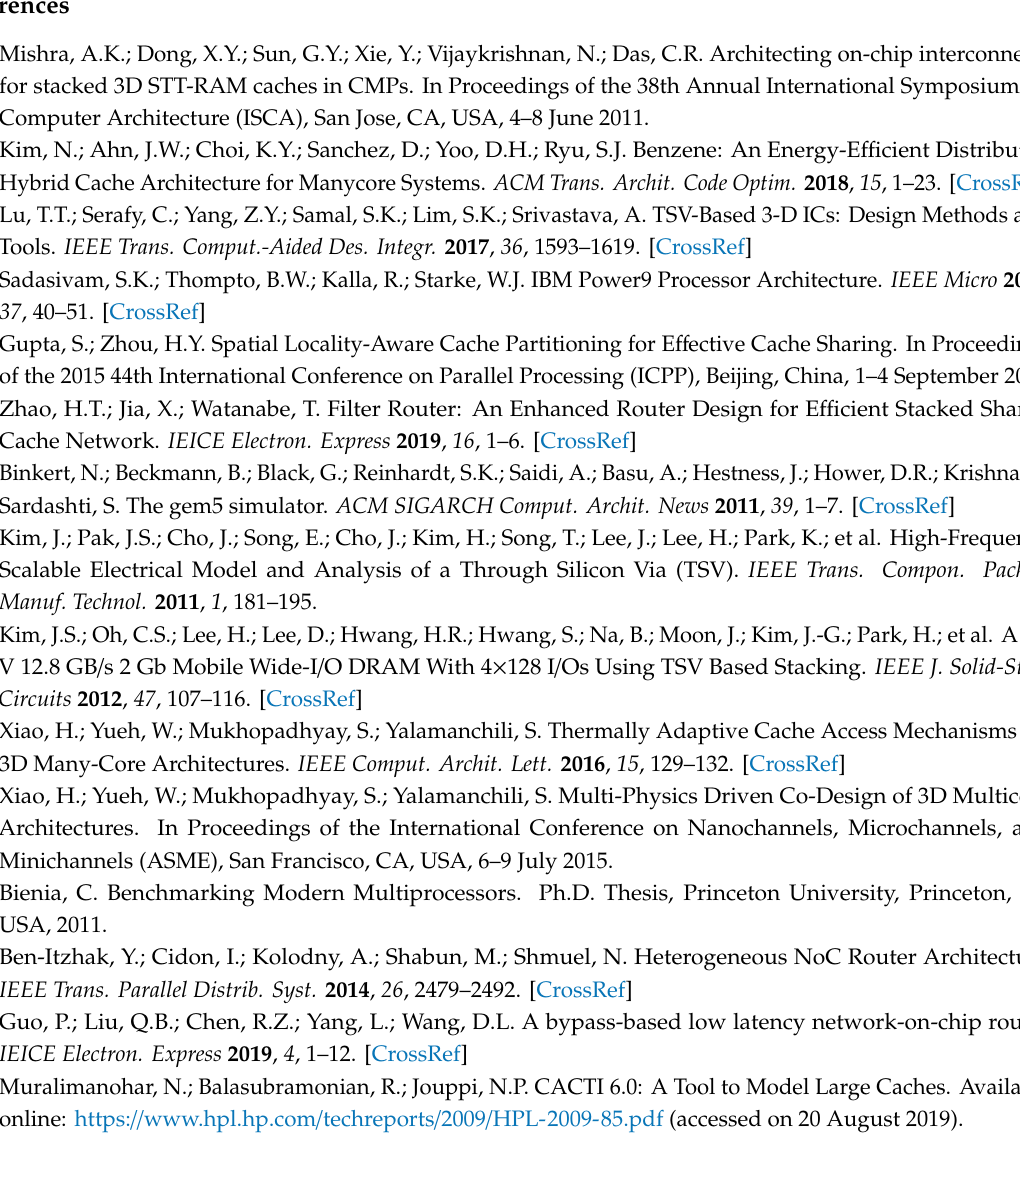
Figure A2. A 5 × 65 TSV array example, vertical pitch (80 μ m) and horizontal pitch (100 μ m) are set.